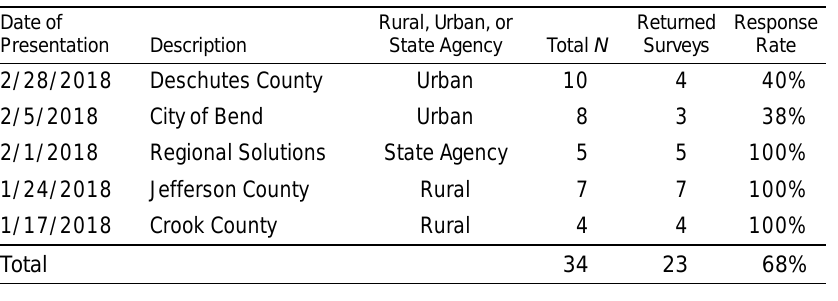
Table 1. Survey Audiences and Response